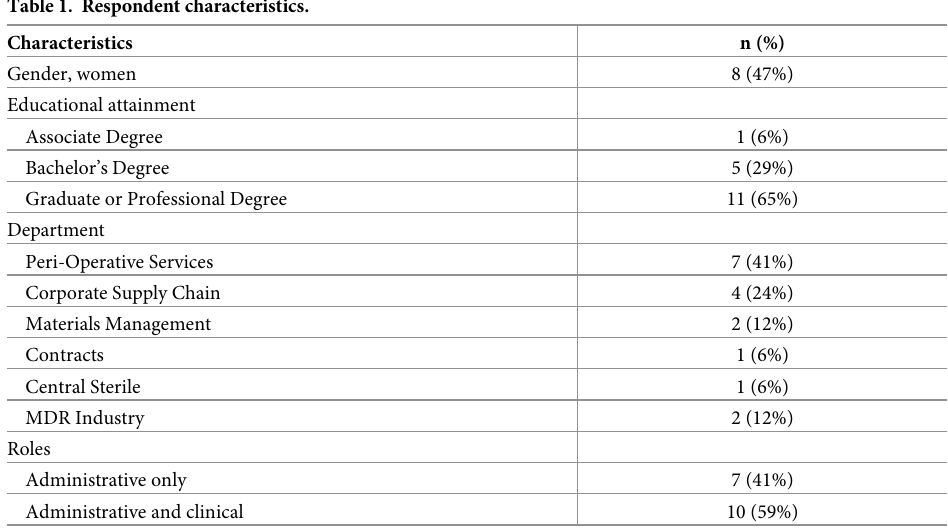
Table 1. Respondent